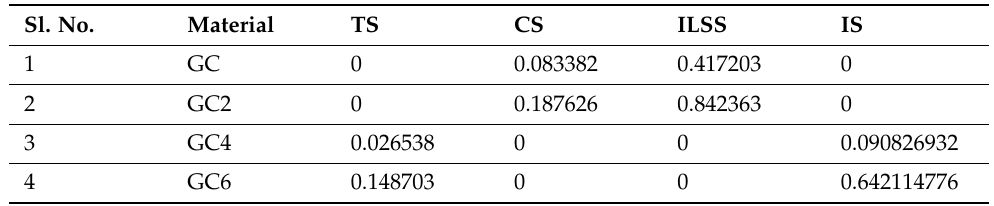
Table 5. Positive Distance from Average (PDA).